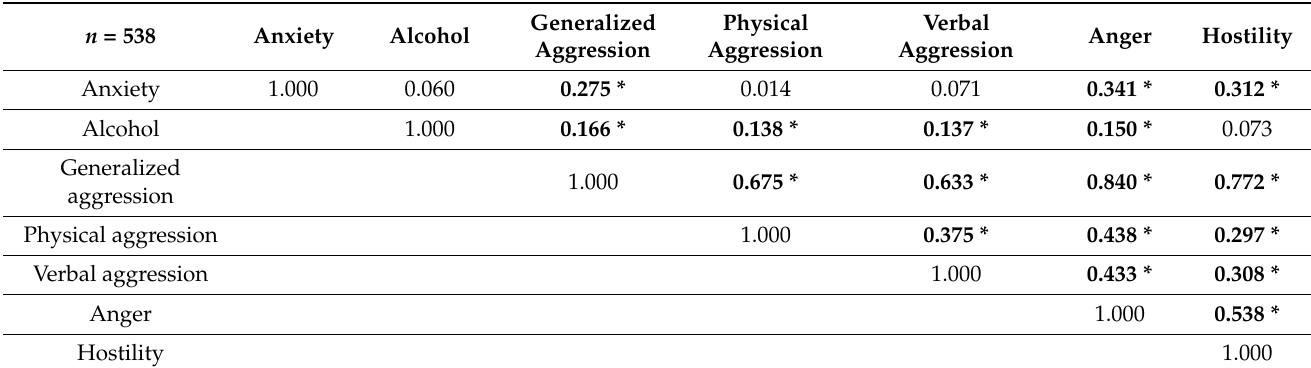
Table 1. Relationships between the severity of anxiety, the level of alcohol consumption and aggression. n =